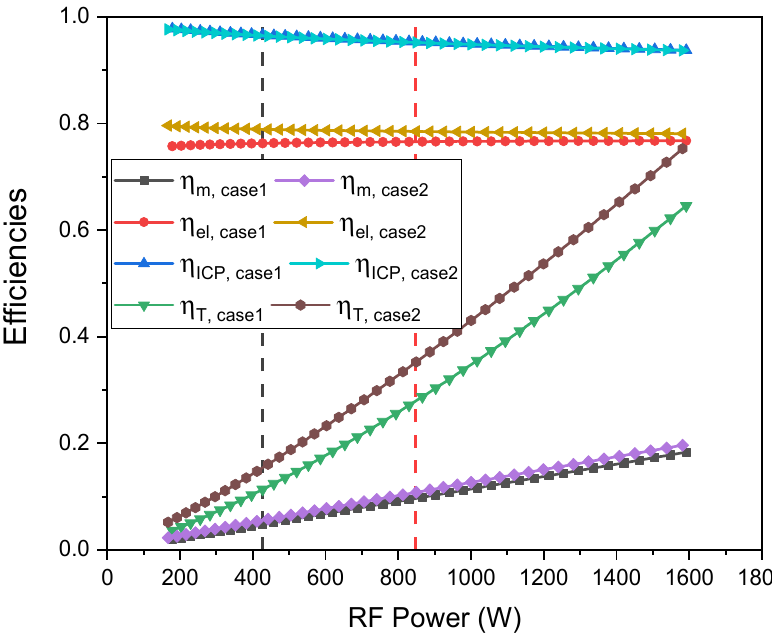
Figure 7. Mass transfer efficiency, η m ; ICP power transfer efficiency, η ICP ; electrical efficiency, η e ; and total efficiency, η T , calculated by global model with (case 1) and without (case 2) the complete set of reactions as a function of the RF Power. Pressure = 2 mTorr.